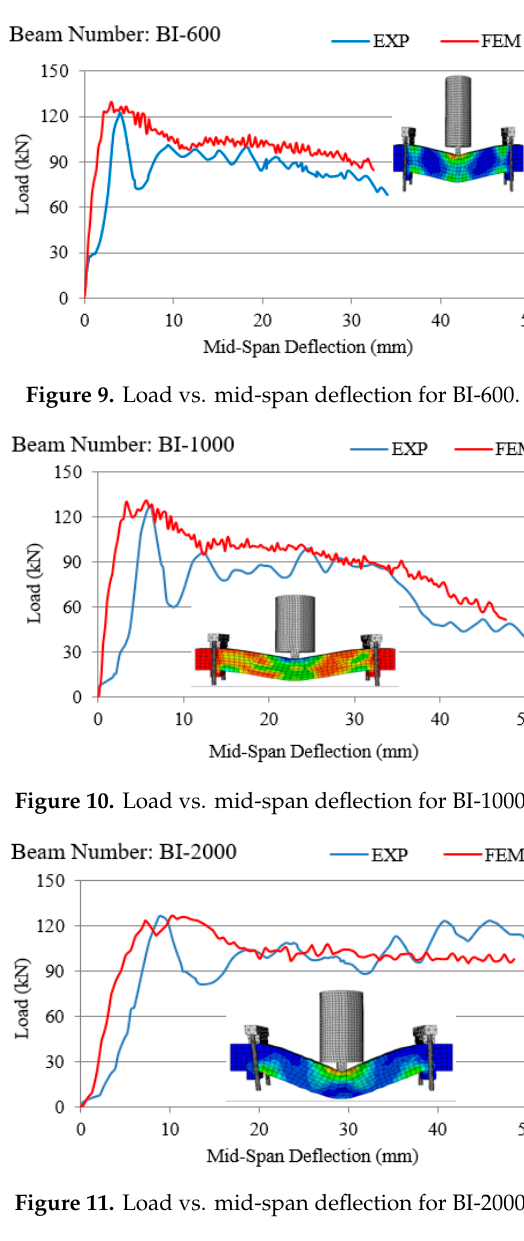
Figure 11. Load vs. mid-span deflection for BI-2000.